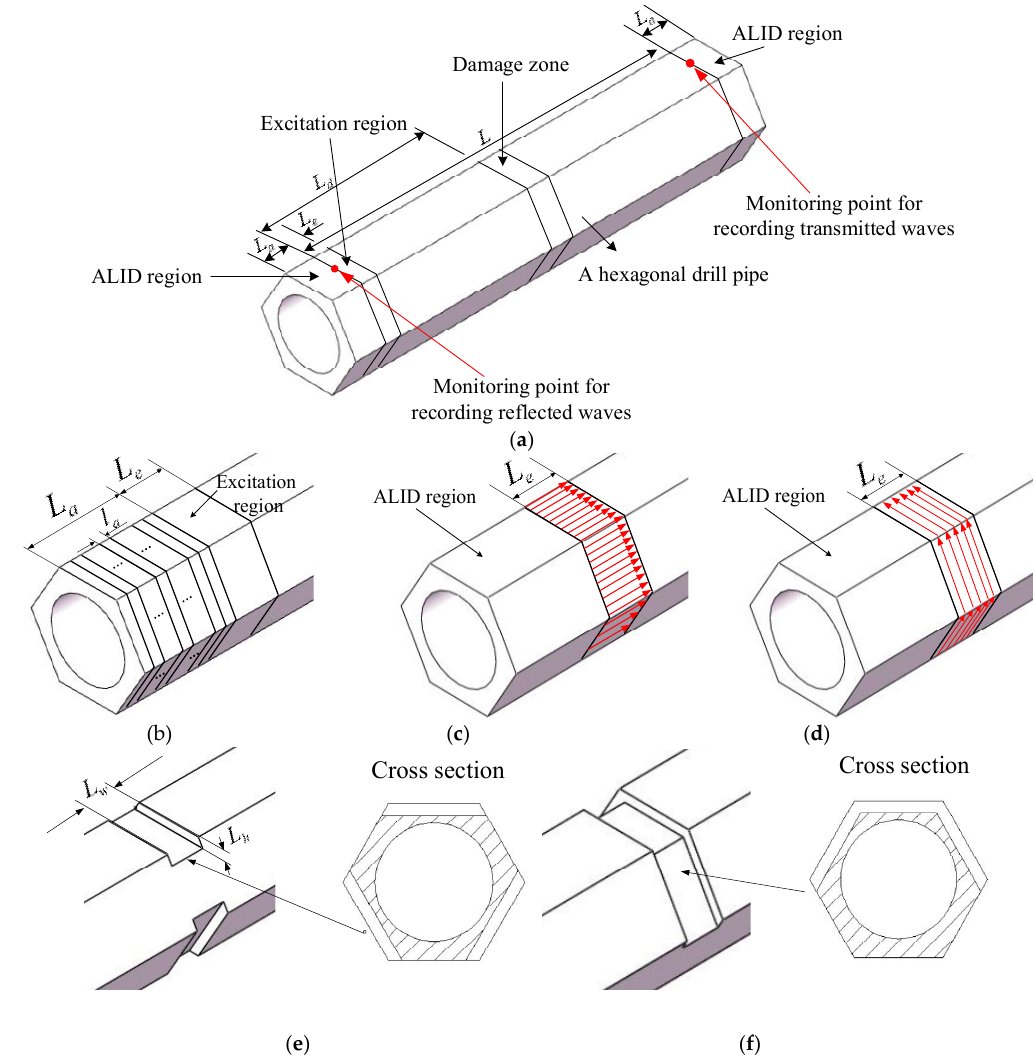
Figure 7. Schematic model for the hexagonal drill pipe: ( a ) Overall finite element model; ( b ) ALID (absorbing layer using increasing damping) model; ( c ) excitation for generating longitudinal modes; ( d ) excitation for generating torsional modes; ( e ) symmetric damage model; and ( f ) asymmetric damage model.